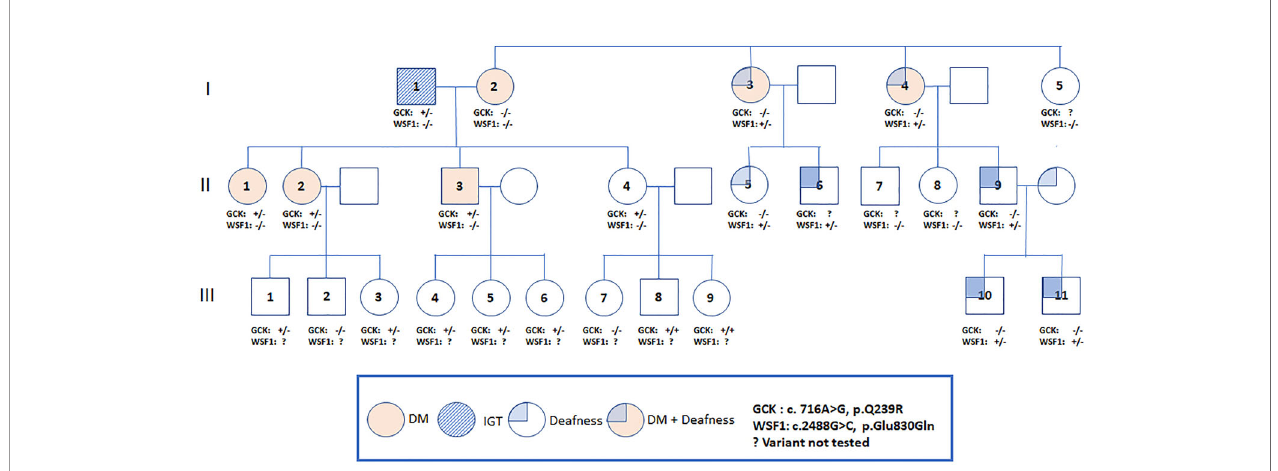
FIGURE 1 | Pedigree of a Thai family with the Q239R mutation in the GCK gene. An arrow indicates the proband. Filled symbols indicate diabetes and non- fi lled symbols indicate normal or unknown glucose tolerance. Carrier status is indicated in those who underwent genotyping (+/+ = homozygous, +/- =heterozygous, -/- =